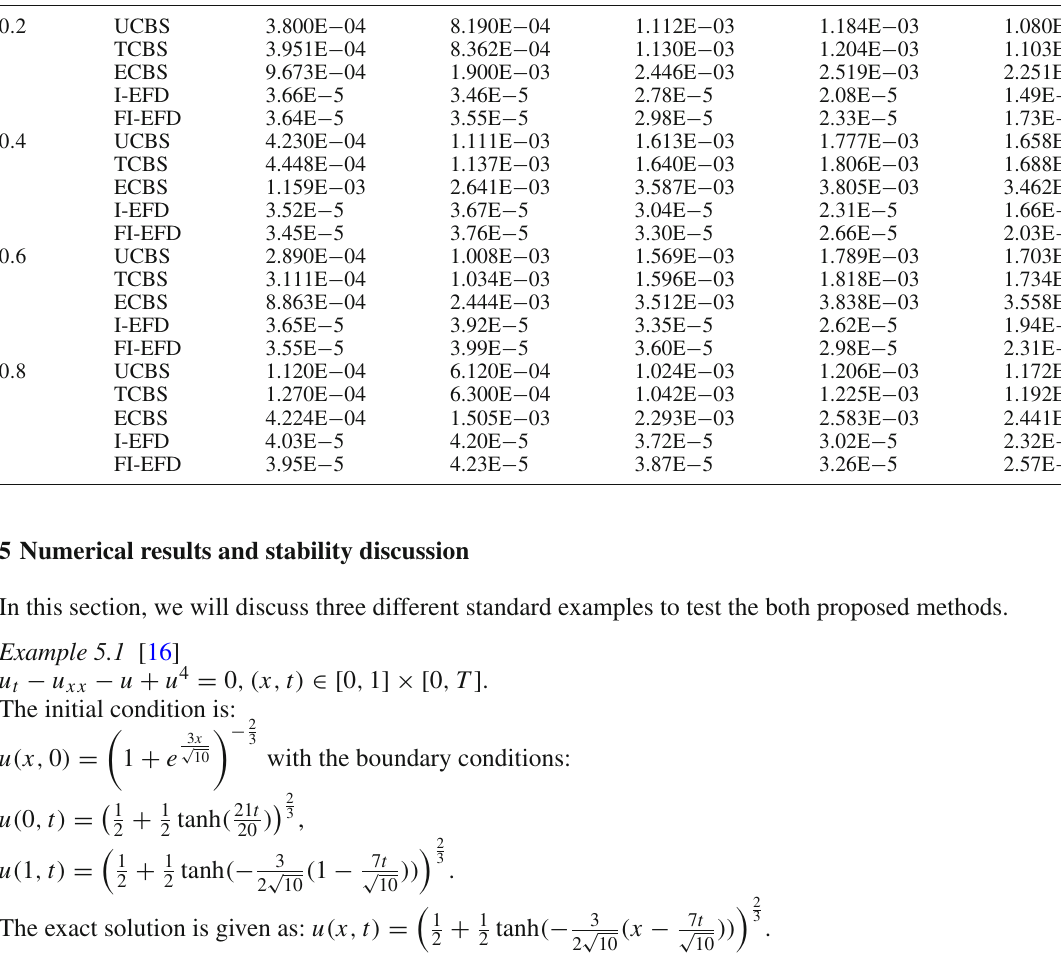
Table 1 Absolute errors of Example 5.1 of I-EFD, FI-EFD (for (cid:2) x = 0 . 0125, (cid:2) t = 10 − 4 ), and the methods of [24] x / t